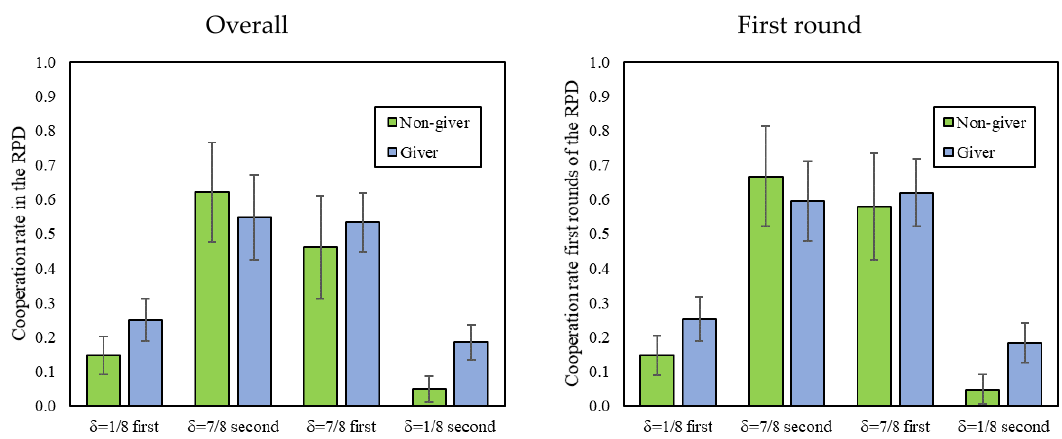
Figure 3. First and overall cooperation in the indefinitely repeated Prisoner’s Dilemma (RPD) of givers vs. non-givers in the Dictator game (DG1), by treatment. In addition, 95% confidence intervals clustered by session.